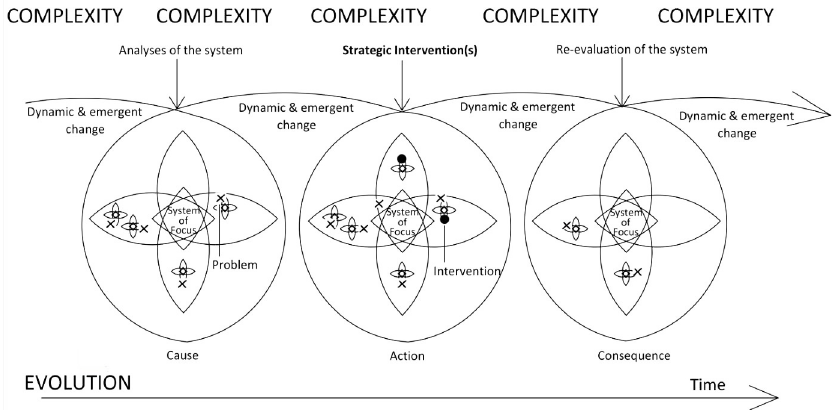
Figure 3. Illustration of the EIMS’ continuing responses to dynamic and emergent urban